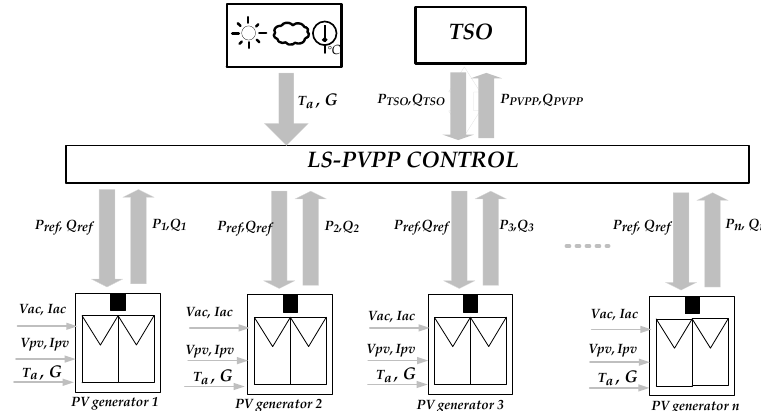
Figure 4. Proposed control architecture for a large scale photovoltaic power plant